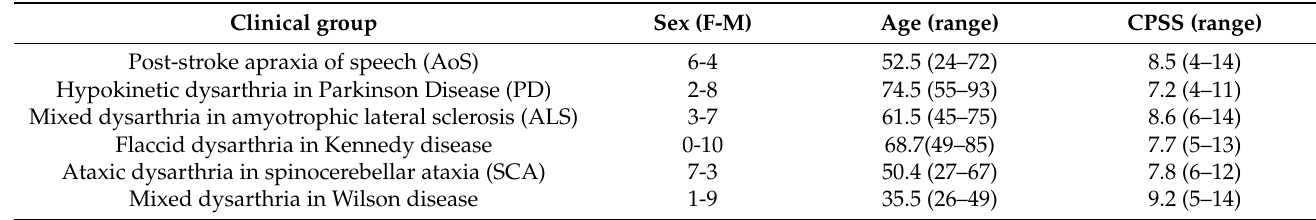
Table 1. Patients’ clinical groups and associated descriptors: sex, age and